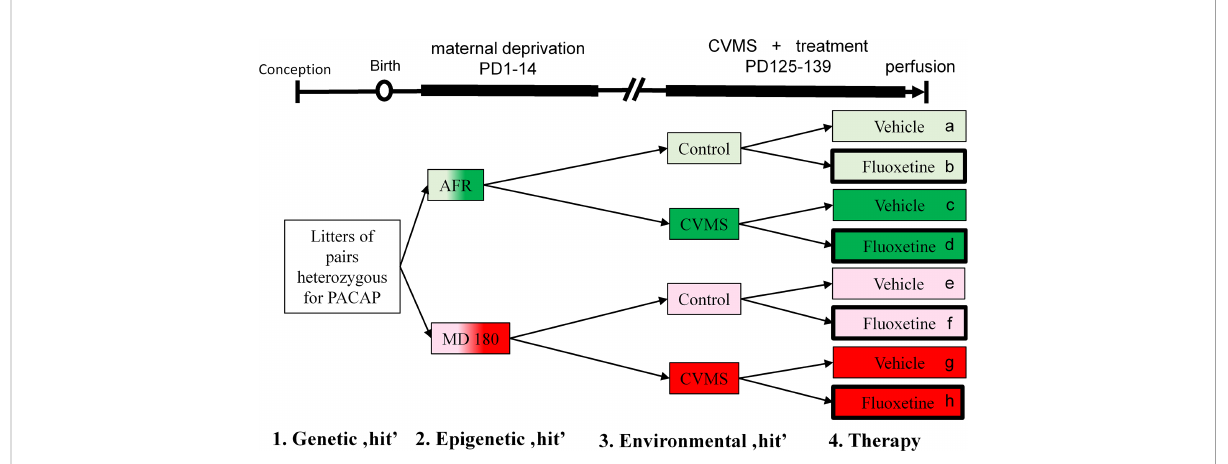
FIGURE 1 Experimental setup and timeline. Lettering (a-h) and corresponding color codes (green: animal facility-reared (AFR) groups, red: groups with history of maternal deprivation, MD180) as well as thick black frames (symbolizing fl uoxetine treatment) were used to refer to the same groups throughout the text and other fi gure diagrams. Control (light shades) and chronic variable mild stress (CVMS)-exposed (dark shades) groups were further divided into vehicle- and fl uoxetine-treated subgroups. PD, postnatal